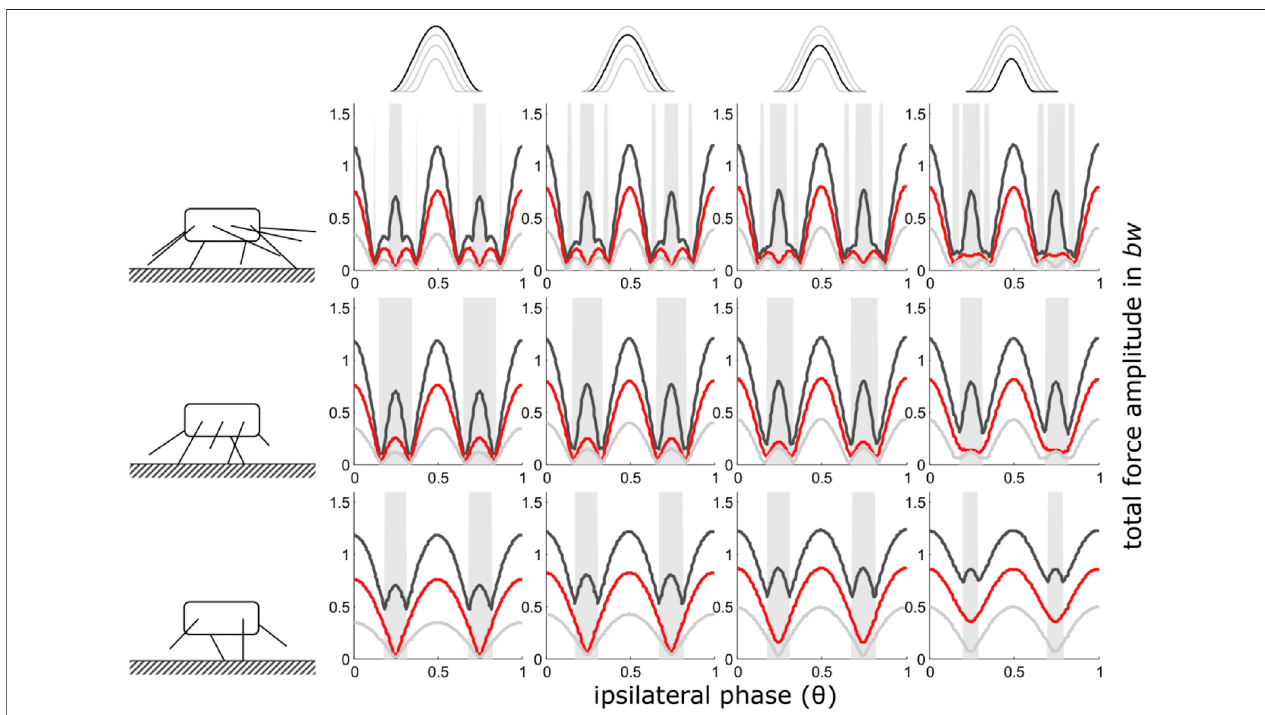
FIGURE 3 | Mid-stance as reference point (iii): Dependency of total vertical leg force amplitudes on the phase shift of ipsilateral adjacent legs and duty factor with gradually decreasing contributions of increasing numbers of leg pairs. GRF decreased while their shape (ratio of width to height) remained constant i.e. also contact durations decreased with the reduction of the impulses beneath leg pairs. Duty factors shown: 0.3 (dark grey), 0.5 (red) and 0.8 (light grey). The top row indicates the degreeofreductioninthepairoflegswithreducedGRFandthetypeofforcealignment(mid-stance(iii)).Accordingly,inthethirdcolumnfromtheright,theimpulse beneathonelegpairisreducedby¼,inthe2 nd columnfromtherightby½andintherightmostcolumnby¾.Thepictogramstotheleftindicatethenumberofpropulsive pairs of legs valid for the respective row of subplots, i.e. four in the upper row, three in the middle row and two in the bottom row. With low duty factors and intermediate phase shifts, the peak frequency of the force oscillations assumed values higher than two times the stride frequency; these intervals are shaded in